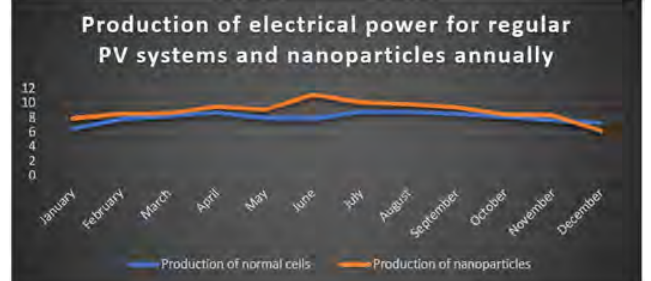
Figure 13. Economic value of solar cell sustainability inthe near term (time efficiency) (”Renewable Energy Technologies Screen”, n.d.).